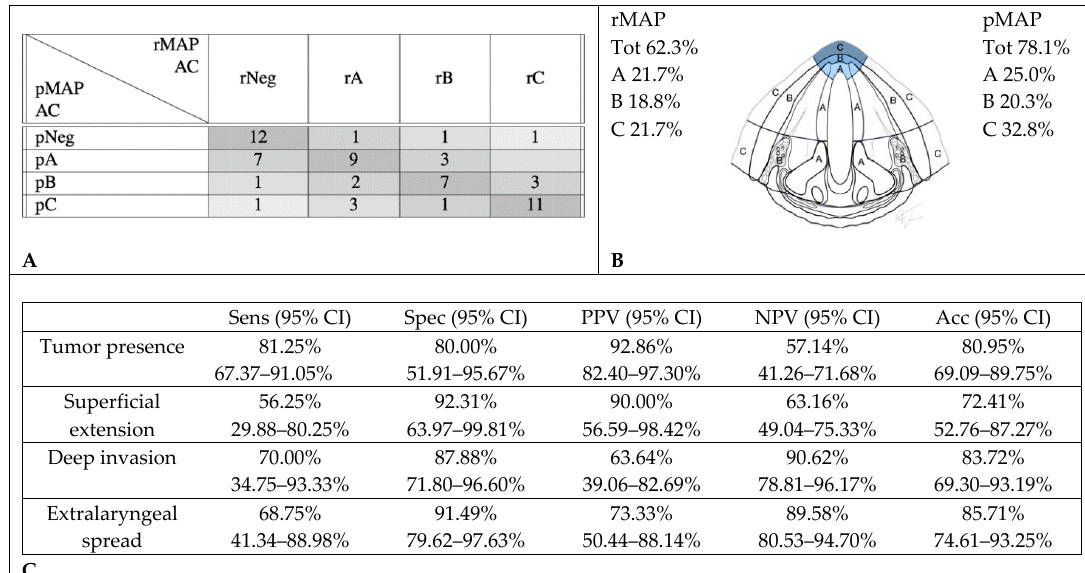
Figure 1. Compared distribution of cT with pT and cTNM with pTNM stages (AJCC 2017). ( A ) Comparison of cT and pT distribution. ( B ) Comparison of cTNM and pTNM stage distribution. In three of six radiologically over-staged cases (50%), a history of previous radiotherapy was described; the two radiologically down-staged cases were the result of false negative neck lymph nodes on CT scans.